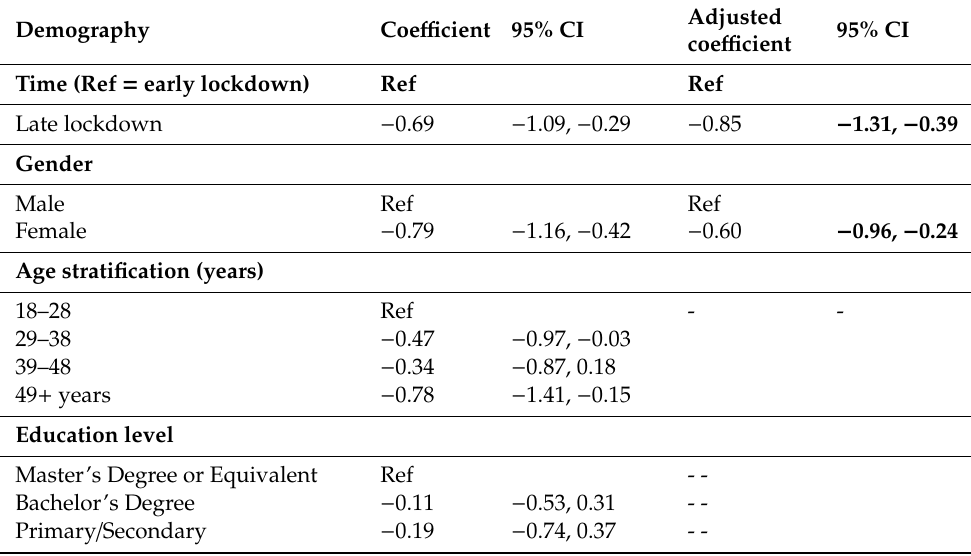
Figure 1. ( a ) Mean and 95% CI of perceived risk towards SARS-Cov-2 in Bangladesh; ( b ) Mean and 95% CI of knowledge towards SARS-Cov-2 in Bangladesh. Table 3. Factors associated with the perceived risk of COVID-19 among the respondents in Bangladesh during the lockdown period. (Bold indicates a significant